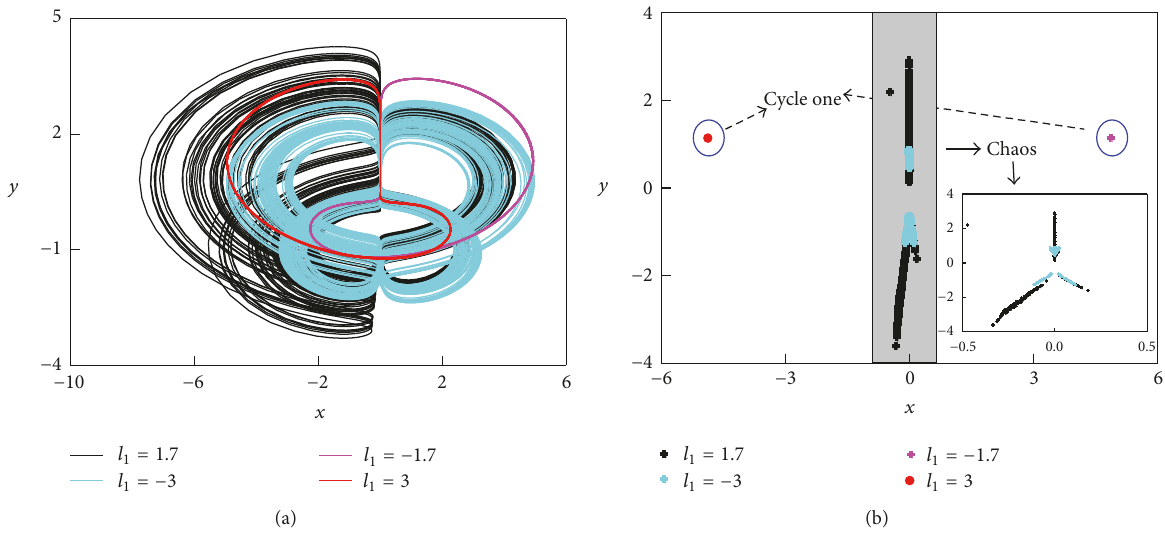
Figure 5: Coexistence of initial value 𝑙 1 changing (a) coexistence phase diagram and (b) coexistence of Poincar´e